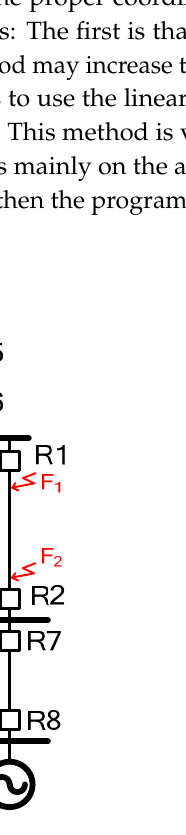
Figure 1. A simple micro-grid showing primary and back-up relays.